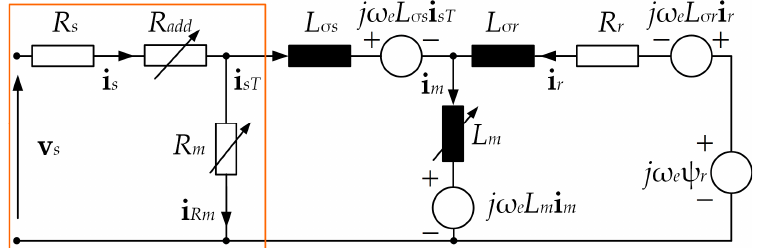
Figure 5. Space vector dynamic equivalent circuit of the SCIG model, including magnetic saturation and variable stray load and iron losses.